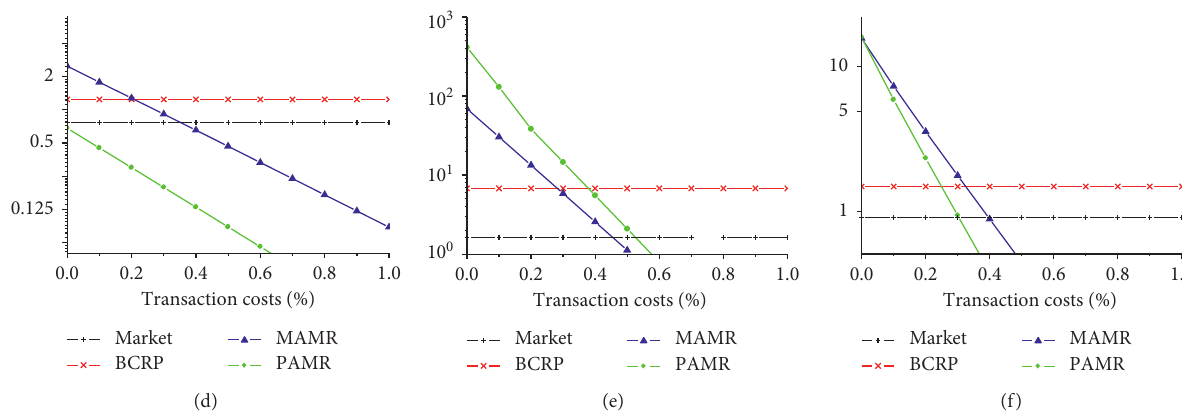
Figure 6: Scalability of MAMR with respect to transaction cost rate. (a) NYSE(O). (b) NYSE(N). (c) SP500. (d) DJIA. (e) TSE. (f)